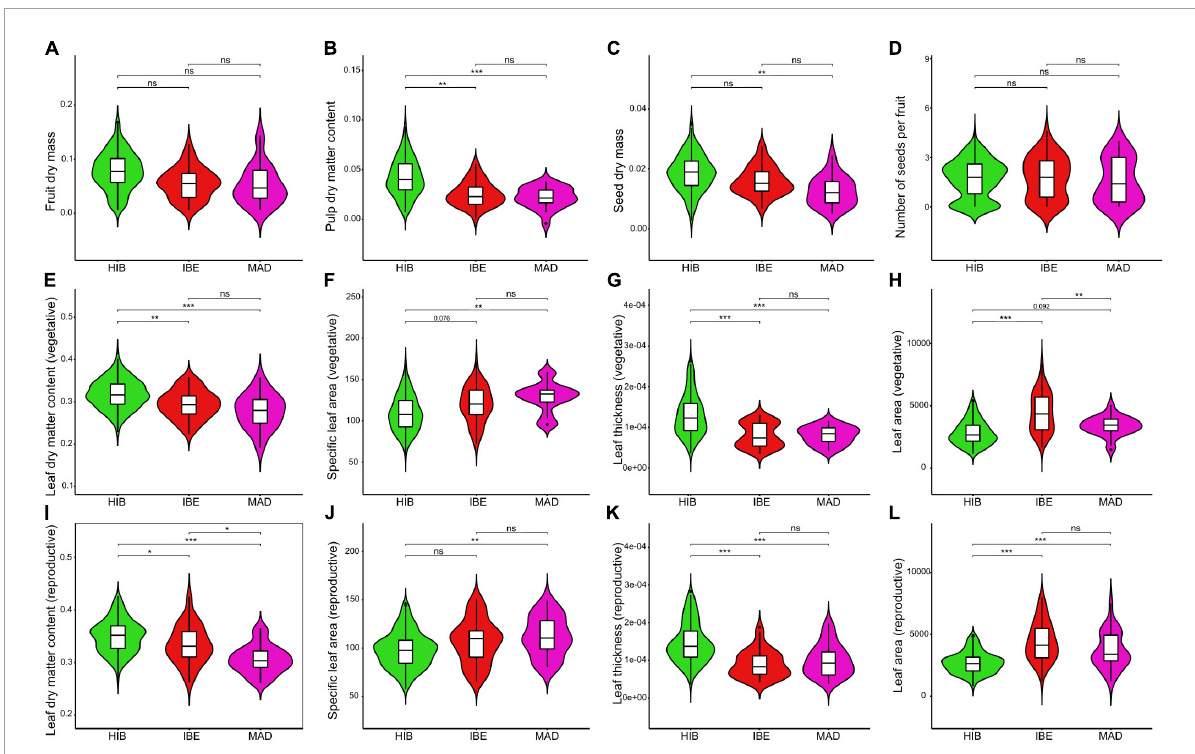
FIGURE4 Fruit (A-D) , vegetative leaf (E-H) , and reproductive leaf (I-L) functional trait differences among the species of the western polyploid clade of Hedera : H. hibernica (HIB), H. iberica (IBE), and H. maderensis (MAD). The crossbar within the boxplot shows the median, and the length of the box indicates the interquartile range. Shape of the violin plot reflects the kernel density plot of data. Level of significance is shown. *** p ≤ 0.001, ** p ≤ 0.01, * p ≤ 0.05, ns p > 0.05. Marginal significance is indicated with the corresponding p